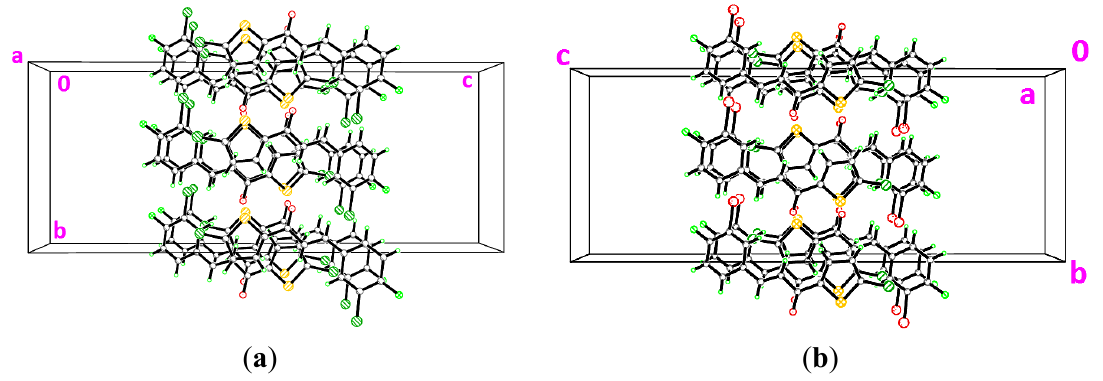
Figure 7. Crystal structures of ( a ) 3d and ( b ) 3e , showing the stacking along the a -axis.